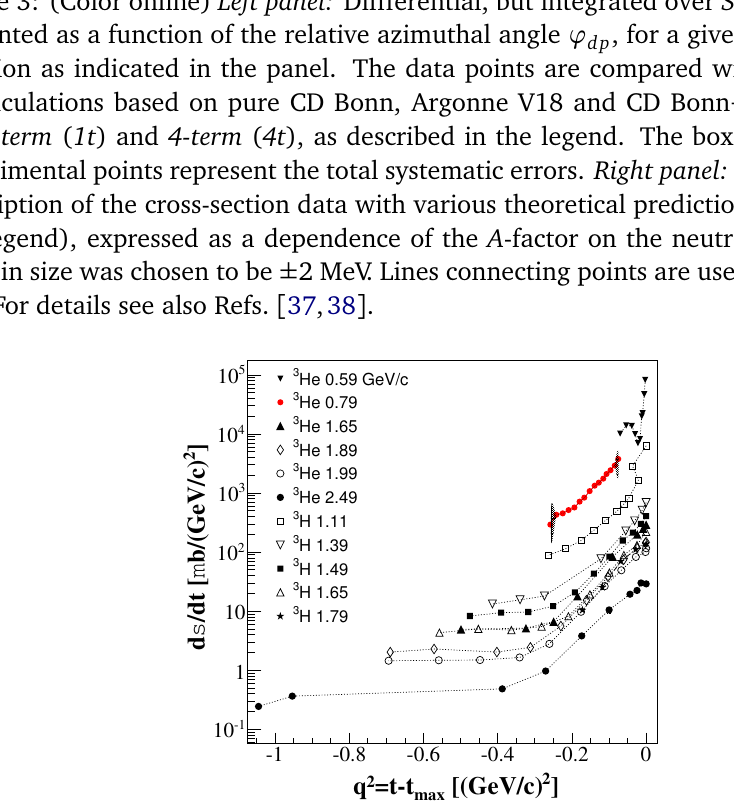
Figure 4: (Color online) Differential cross sections for transfer reactions in d - d scat- tering q 2 [ 29,30 ] . The data from the BINA experiment at 0.79 GeV / c are shown as red points. The dark band represents systematic errors. For more details see Ref. [ 33 ] .